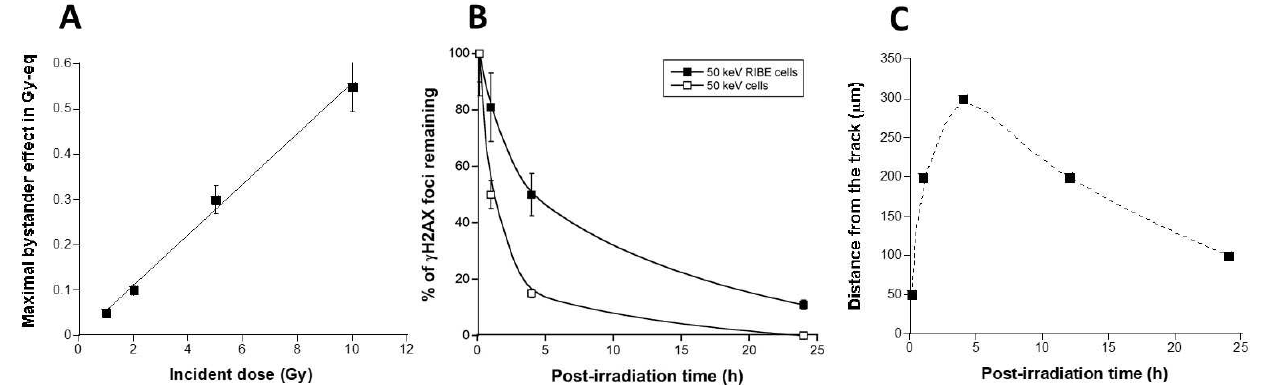
Figure 4. Specificities of the RIBE induced after a 50 keV synchrotron X-rays micro-irradiation in the 1BR3 fibroblasts. ( A ) Maximal RIBE expressed in Gy-equivalent (Gy-eq) as a function of dose (Gy) and deduced from the data shown in Figure 3C,D. These data were fitted to a linear formula (y = −0.00255 + 0.056 x; r = 0.997) (solid line). ( B ) RIBE DSB repair kinetics. The 10 µm γH2AX data shown in Figure 3 (2 Gy data) were plotted against the corresponding repair times. The resulting DSB repair kinetic of RIBE cells (closed squares) was compared with the DSB repair kinetic obtained with the same cell lines but from a standard (direct) 50 keV X-rays irradiation (open squares). These data were fitted to the Bodgi’s formula (solid lines) [47]. ( C ) From data shown in Figure 3, the distance from the track at which the number of γH2AX foci was found maximal was plotted against the corresponding post-irradiation time. Data were linked together with a smooth fit (dotted line).